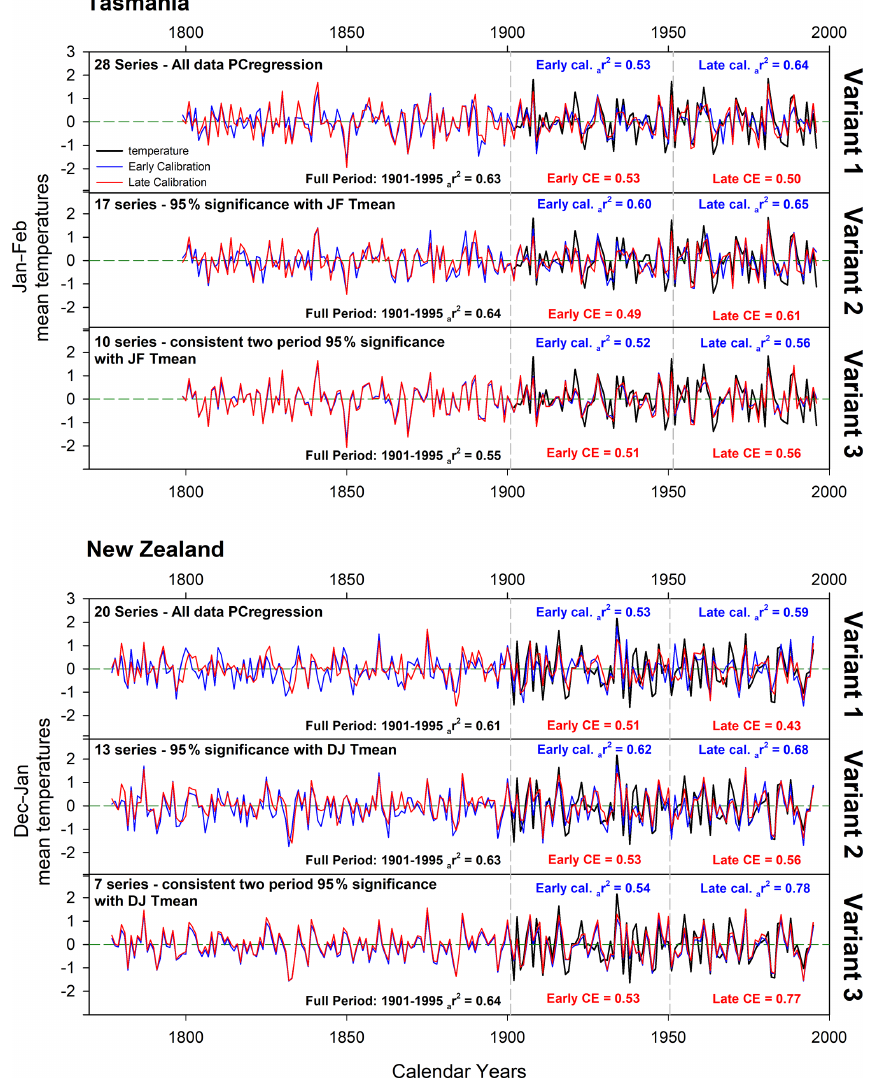
Figure 4. Principal component regression results using all data (variant 1), full-period (1901–1995) screened data (variant 2), and two-period screening (variant 3). Split period calibration and validation were performed over 1901–1950 and